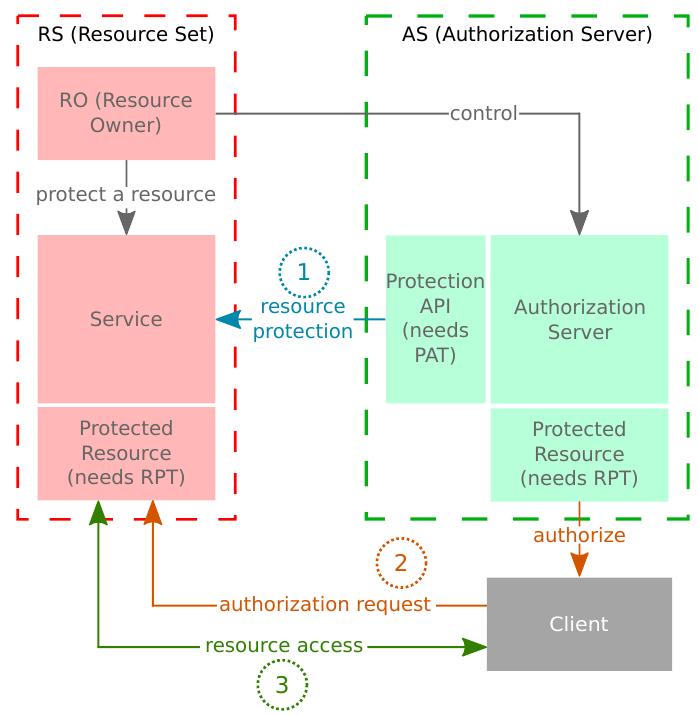
Figure 2. The main phases and entities of User-Managed Access (UMA). PAT: Protection API Token; RPT: Requesting Party